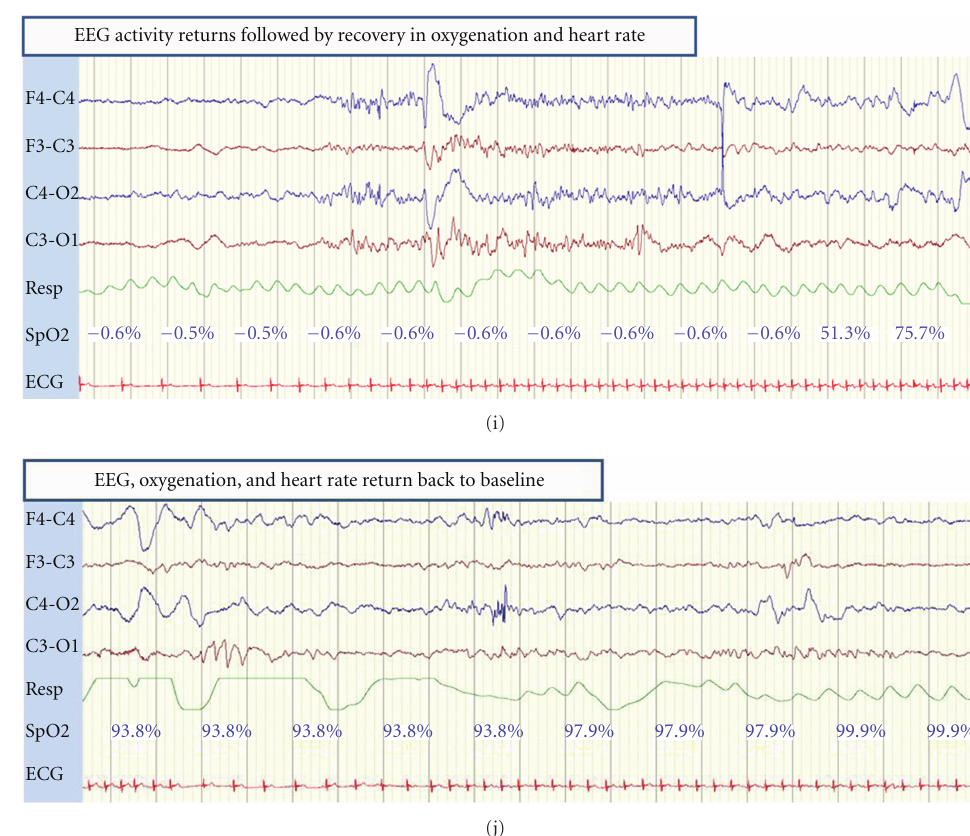
Figure 1: EEG recording showing the sequence of events evolving from baseline values associated with the first episode of complete EEG suppression. Calibration is 1 second and 50